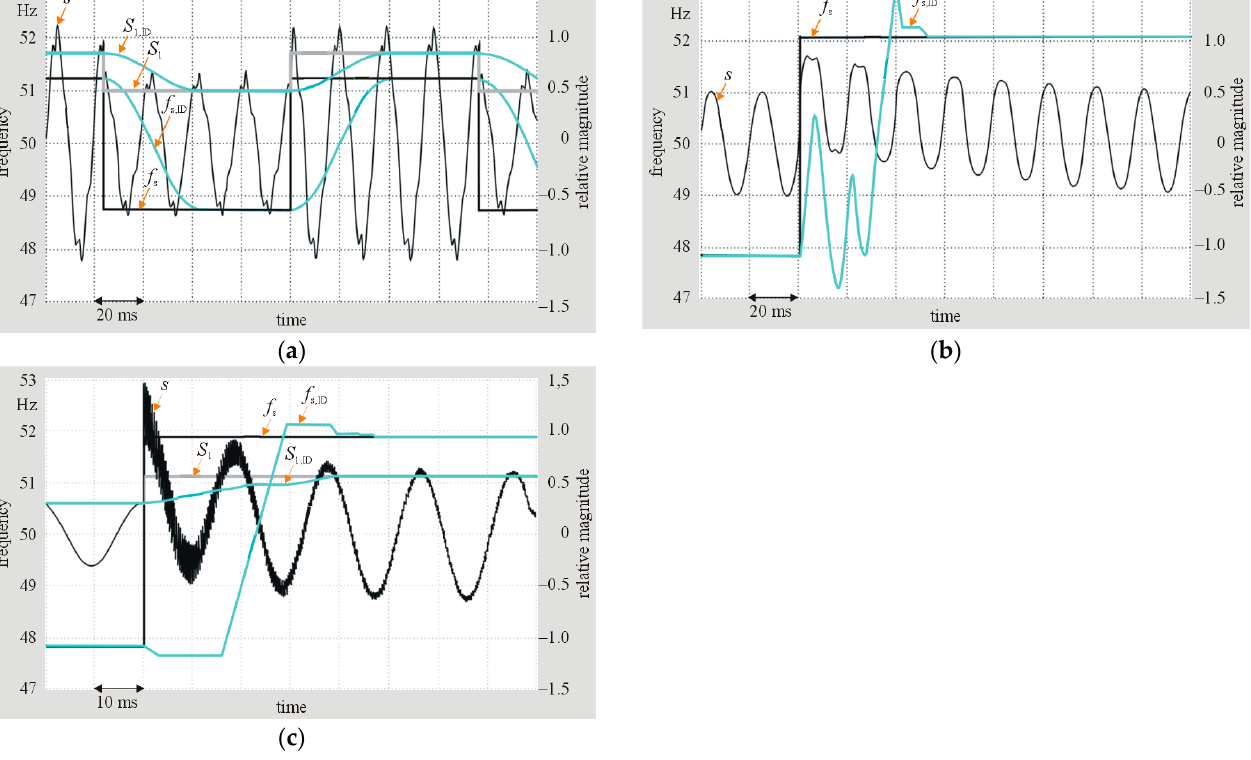
Figure 8. Results of the tests of the algorithm. Response of the IS to a step-change in the measured signal frequency in the range of ( a ) 50 ± 1.2 Hz, ( b ) 50 ± 2.1 Hz, and ( c ) 50 ± 2.0 Hz, with different degrees of its deformation, and step-change of the input signal magnitude ( a ), presence in the input signal of the transient component ( b , c ), and the presence in the input signal of a high-frequency component ( c ).